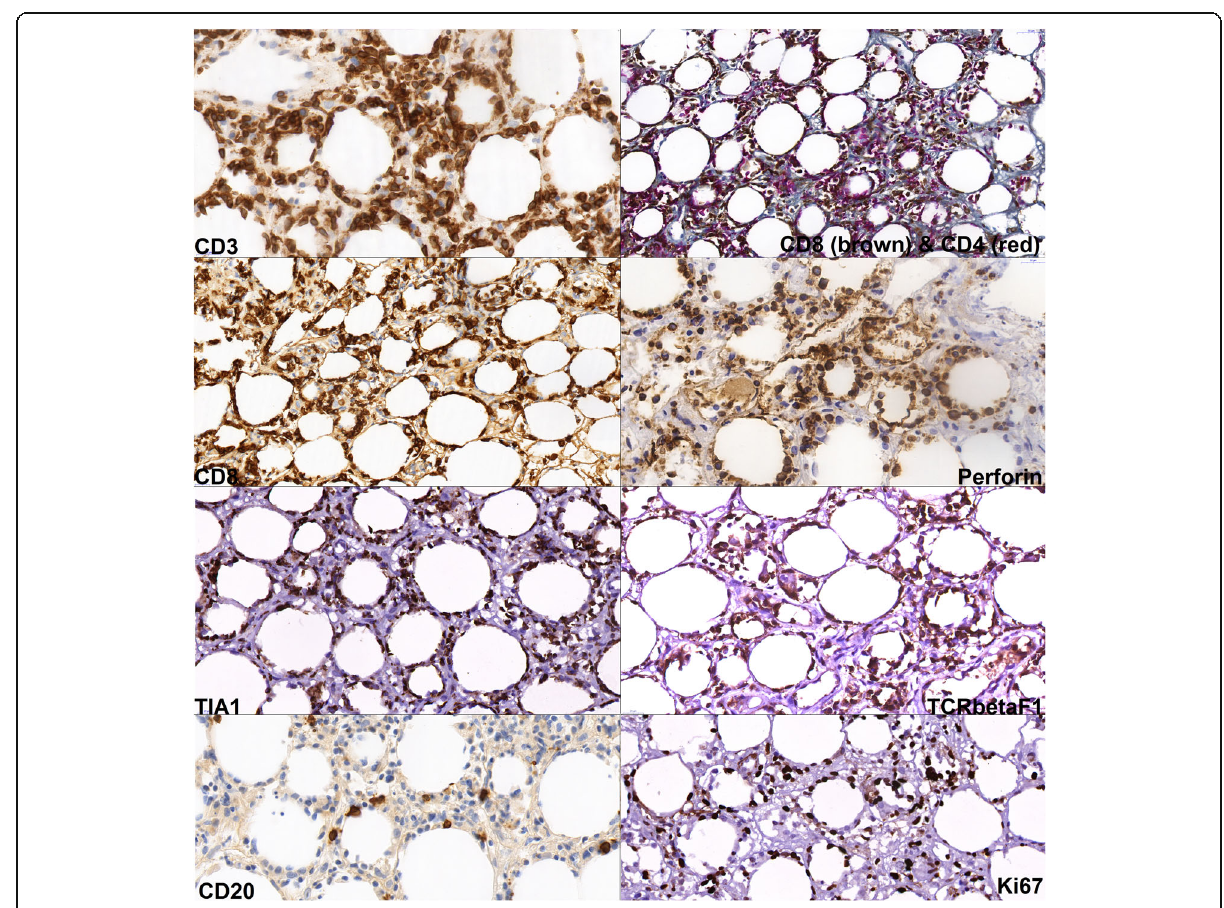
Fig. 3 immunohistochemistry showing neoplastic lymphocytes with positivity of CD3, CD8, perforin, TIA-1 and TCR β F1. CD4 stains rather bystander T-cells and histiocytes, without unequivocal positivity in lymphoma. The neoplastic cells are CD20 negative, note the sparse CD20- positive reactive B-cells. The neoplastic lymphocytes embody proliferation activity (Ki67) about